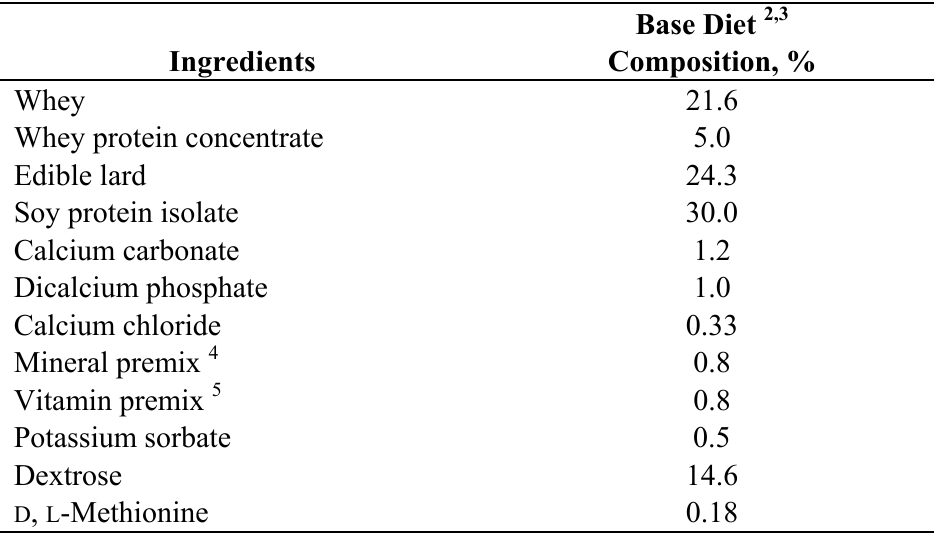
Table 1. Experimental diet composition on an as fed basis 1